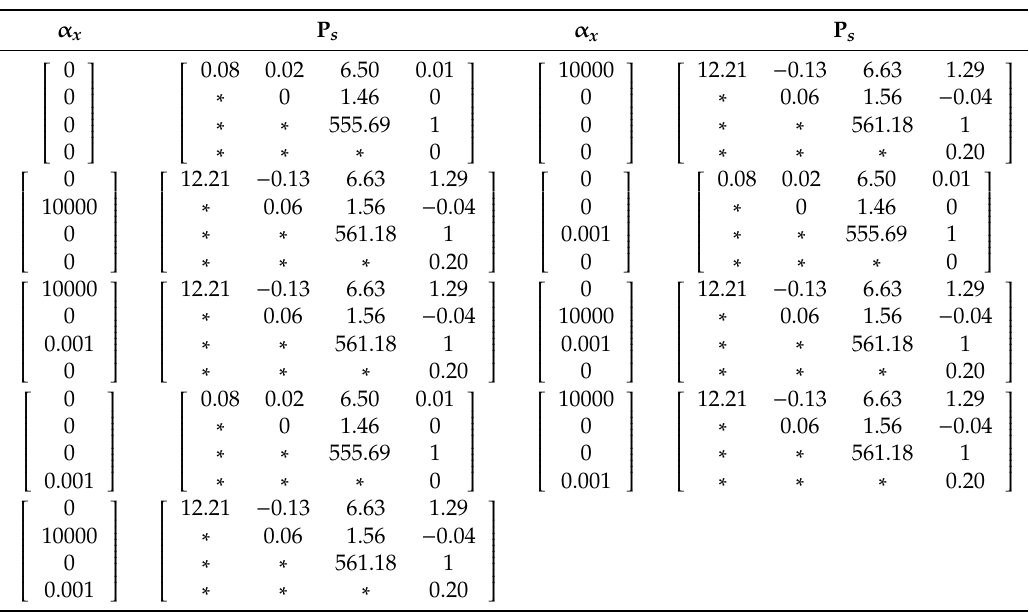
Table 2. Examples of the solutions of